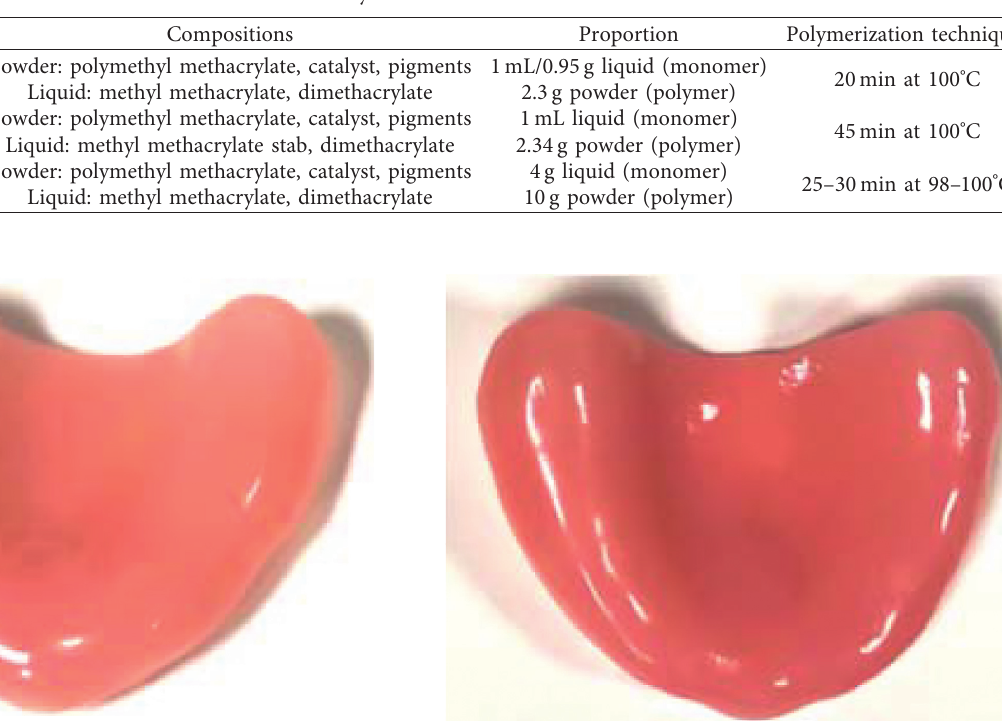
Figure 1: Example of an acrylic resins RS Vertex ® sample.